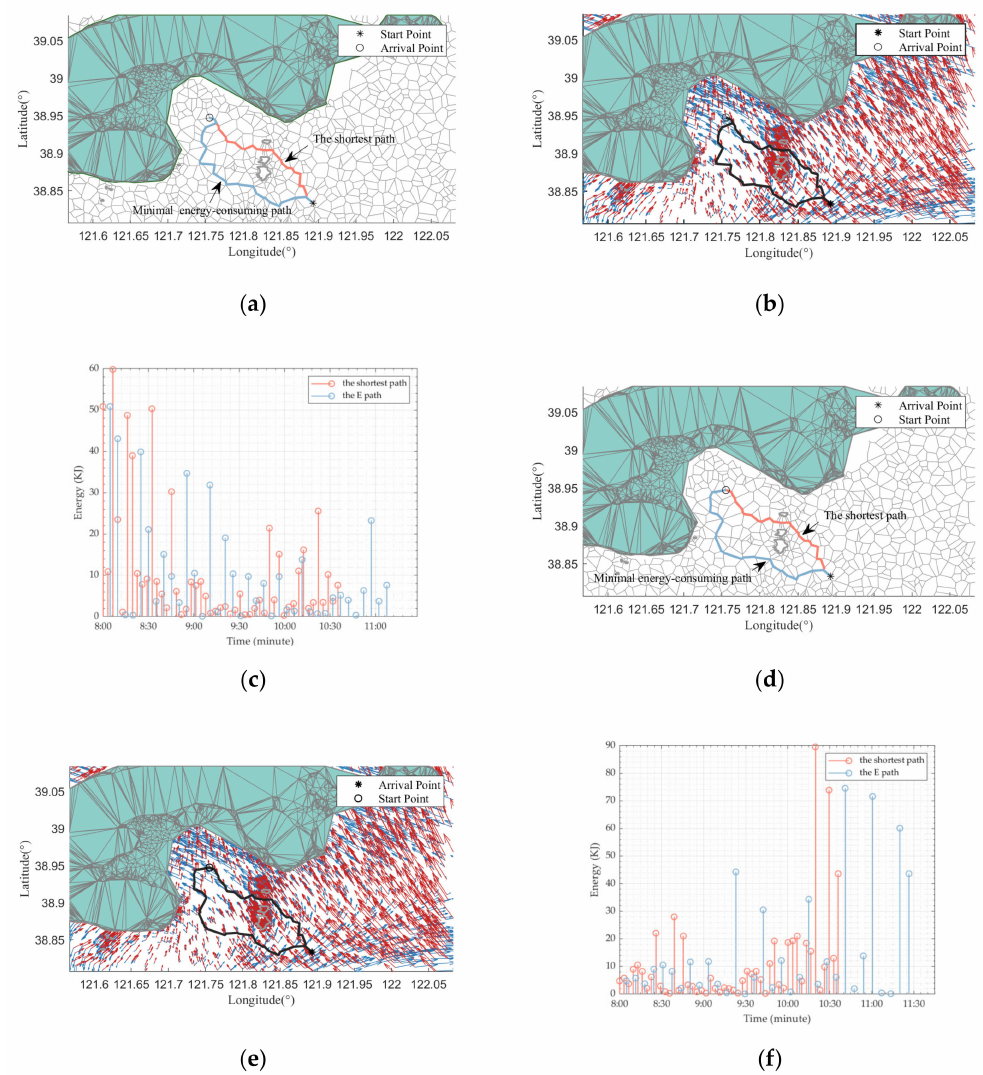
Figure 13. Comparison between the minimal energy-consuming path and the shortest path. ( a , b ) Comparison between the minimal energy-consuming path and the shortest path in a favorable situation. ( c ) represents the energy consumption over time in a favorable situation. ( d , e ) Compari- son between the minimal energy-consuming path and the shortest path under a counter situation. ( f ) represents the energy consumption over time in a contour